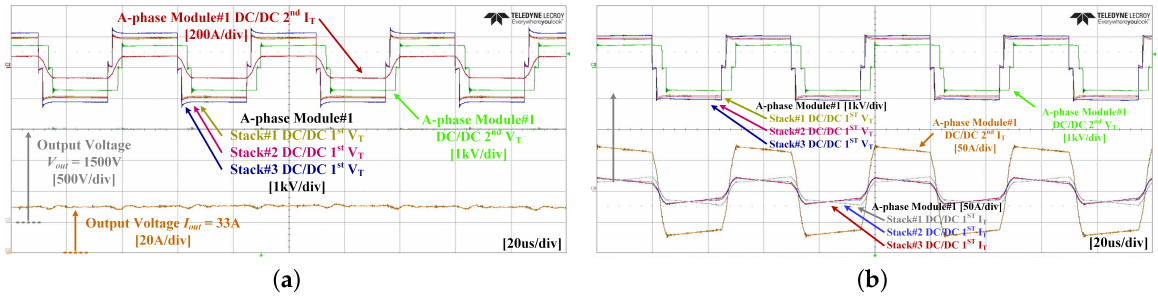
Figure 13. Experimental results of the QAB converter under 50 kW rated load condition: ( a ) steady- state waveform; ( b ) high-frequency isolation transformer consisting of a 4-winding waveform.